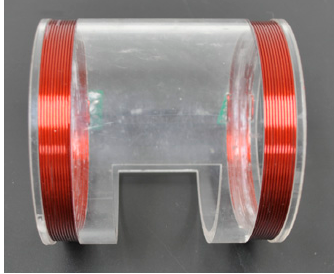
Figure 2. The two-coil sensor for rabbits experiment.